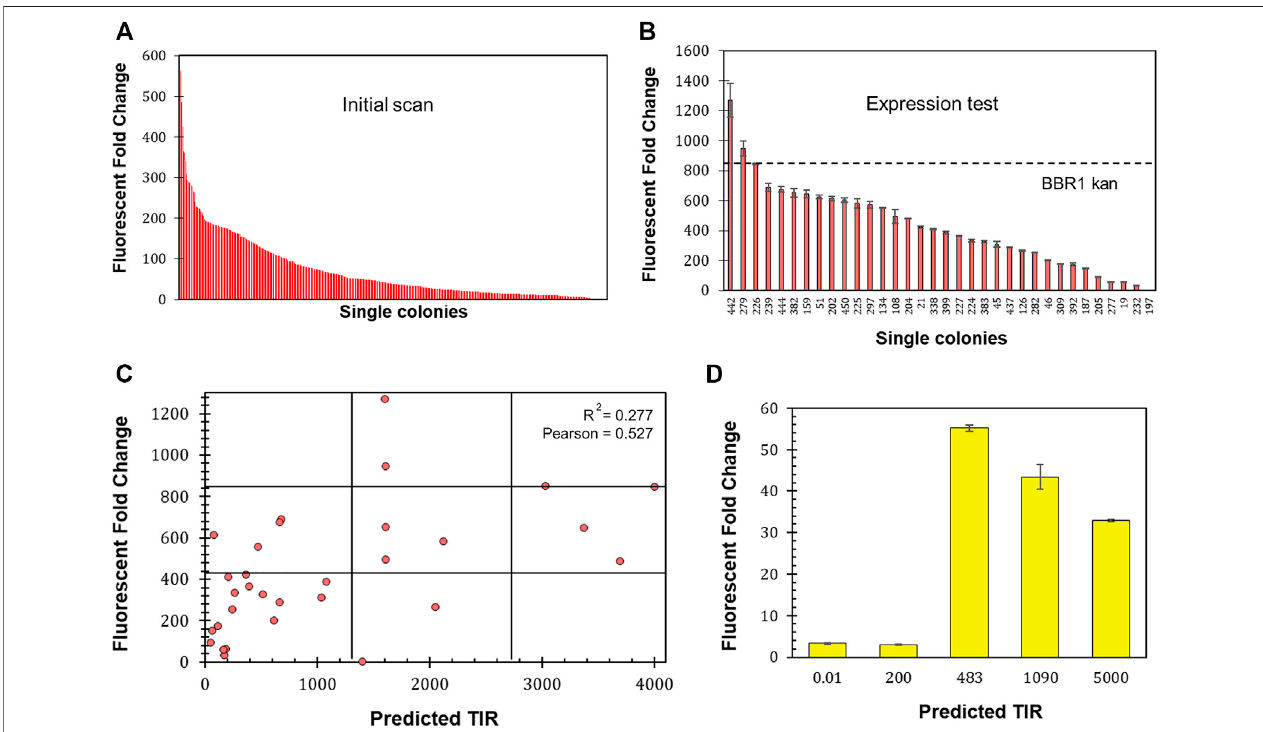
FIGURE 7 | Determining 5 ′ UTR design guidelines for R. palustris . (A) Fluorescent fold change scan of R. palustris BBR1-kan-mRFP (RBS library) single colonies (Materials and Methods). (B) Average fl uorescent fold change of select R. palustris BBR1-kan-mRFP (RBS library) strains grown in triplicate (Materials and Methods). Error bars represent the population standard deviation. (C) Comparison of the predicted translation initiation rate (TIR) versus the fl uorescent fold change average of the select R.palustris BBR1-kan(RBSlibrary)-mRFPstrains.Thegridlinesdivideeachaxisinthirdstoaidinanalysis. (D) Average fl uorescentfoldchangeof R.palustris BBR1-kan (0.01, 200, 483, 1,090, and 5,000)-5 ′ UTR-eYFP strains grown in triplicate (Materials and Methods). Error bars represent the population standard